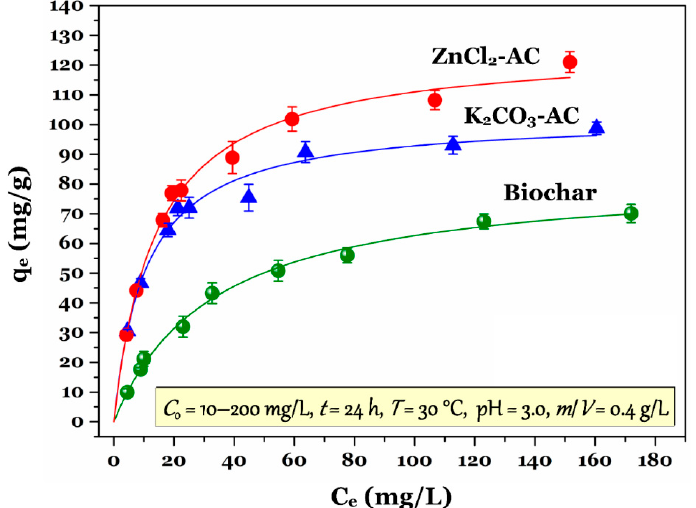
Figure 4. Adsorption isotherm of Cr(VI) by the prepared biochar and activated carbon samples (Note: the data are represented as average ± standard deviation).